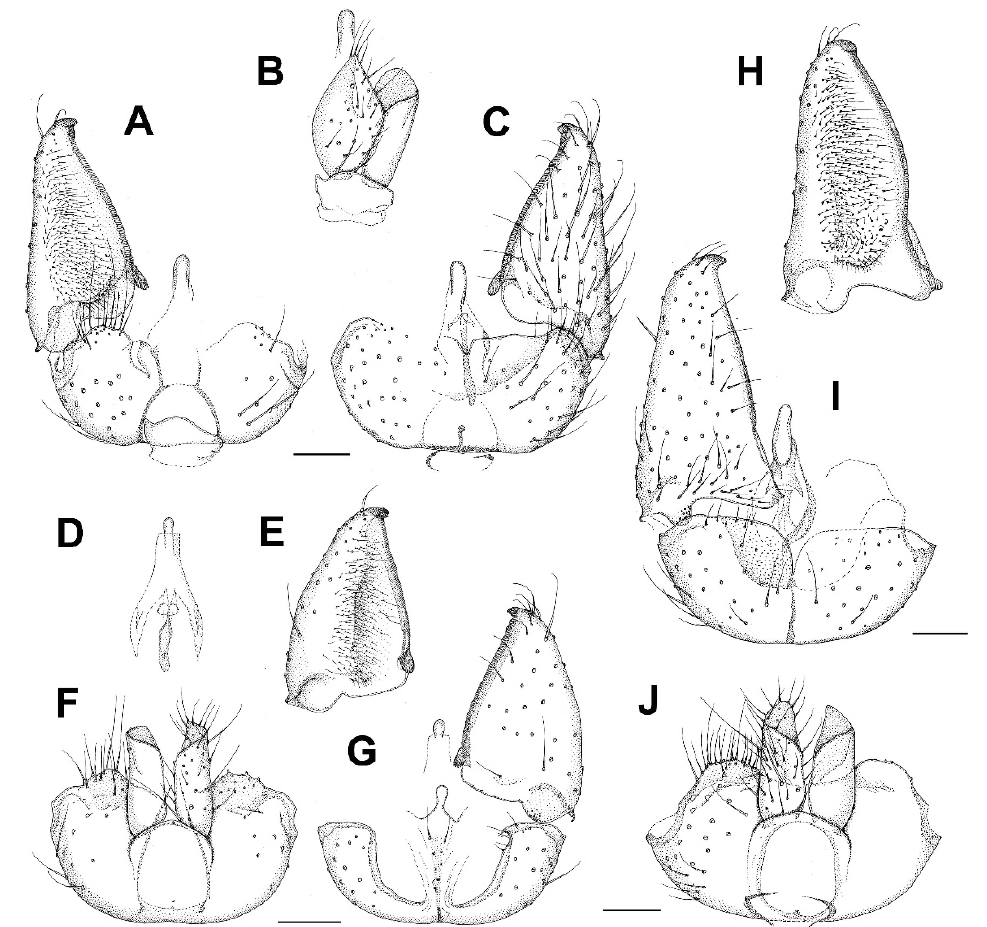
Figure 8. Male terminalia of Asioditomyia Saigusa. Asioditomyia bruneicola sp. nov. (holotype): ( A ) dorsal view, ( B ) cerci, ( C ) ventral view; Asioditomyia lacii sp. nov. (holotype), ( D ) aedeagus in ventral view, ( E ) gonostylus in dorsal view, ( F ) dorsal view with cerci, ( G ) ventral view; Asioditomyia japonica (Sasakawa), ( H ) dorsal view of gonostylus, ( I ) ventral view, ( J ) dorsal view with cerci. Scale bars: 0.1 mm.